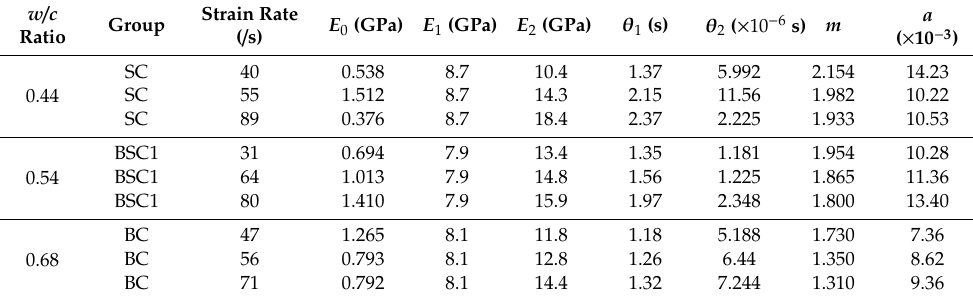
( b ) BSC1– w/c ratio: 0.54; ( c ) SC– w/c ratio: 0.44. Table 6. The fitted parameters of BSFRC under di ff erent strain